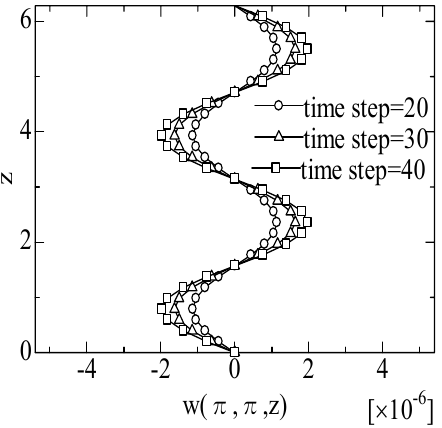
Fig. 8 Distribution of velocity w at x = ( π , π ,z).